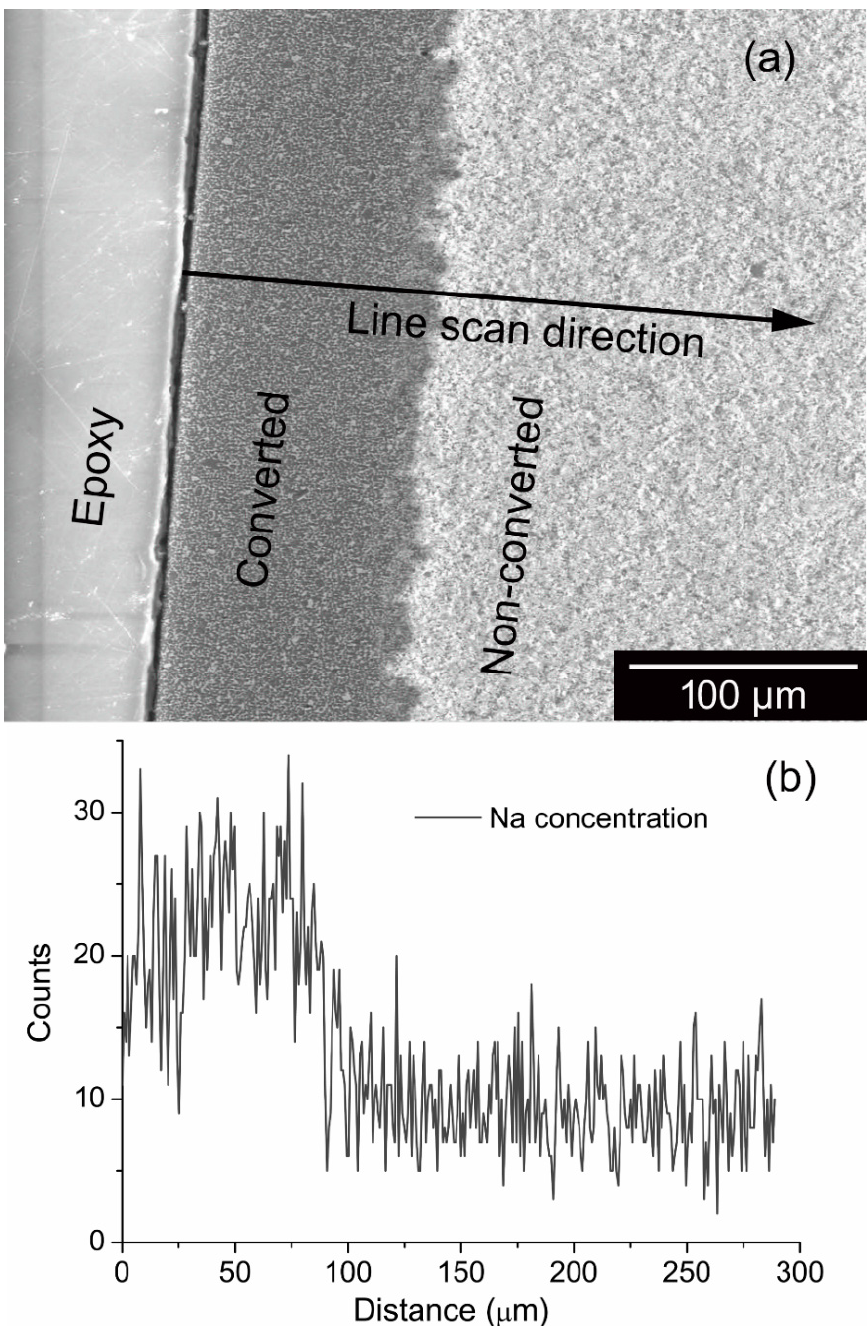
Figure 2. ( a ) An SEM image showing the converted and the pristine regions of the initially α -alumina + YSZ sample after 4 h of conversion at 1250 °C. ( b ) The corresponding EDS line scan is indicated by the arrow.